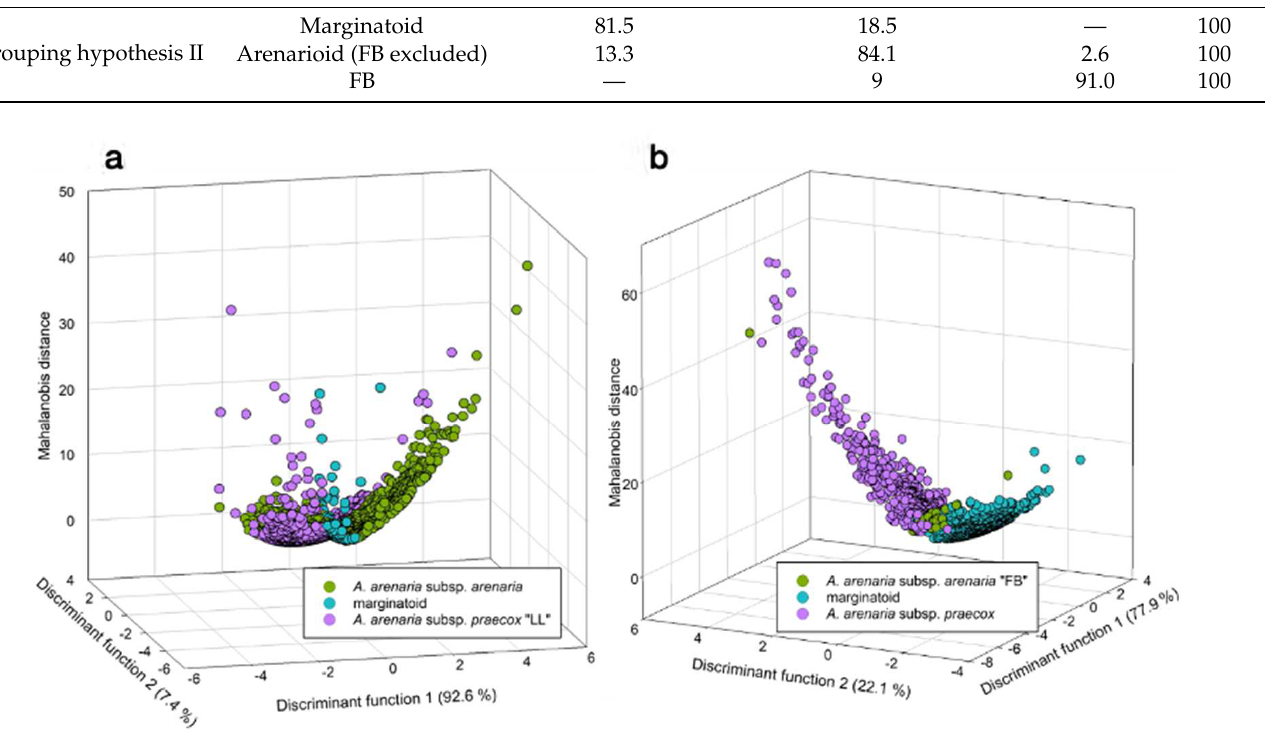
Figure 3. Graphical representation of the linear discriminant analysis (LDA) for the alternative grouping hypothesis for Armeria arenaria populations. ( a ) Grouping hypothesis I; ( b ) Grouping hypothesis II. FB = Fontainebleau, Île–de–France; LL = Le Lauzet, Dauphiné Alps.